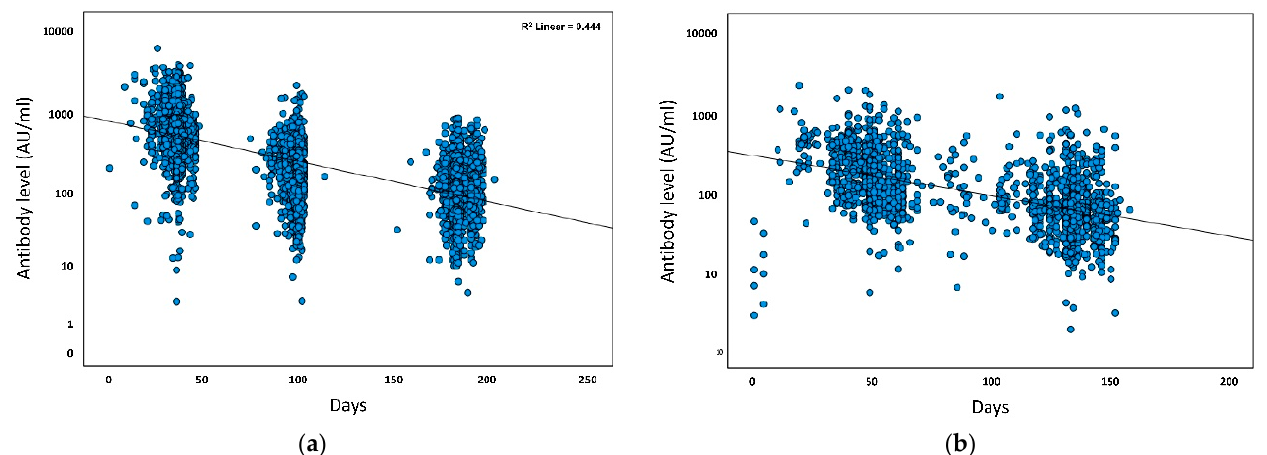
Figure 2. Comparison of antibody concentrations and time for the second and third vaccine doses. ( a ) Time between second vaccine dose and antibody test (days); ( b ) Time between third vaccine dose and antibody test (days).